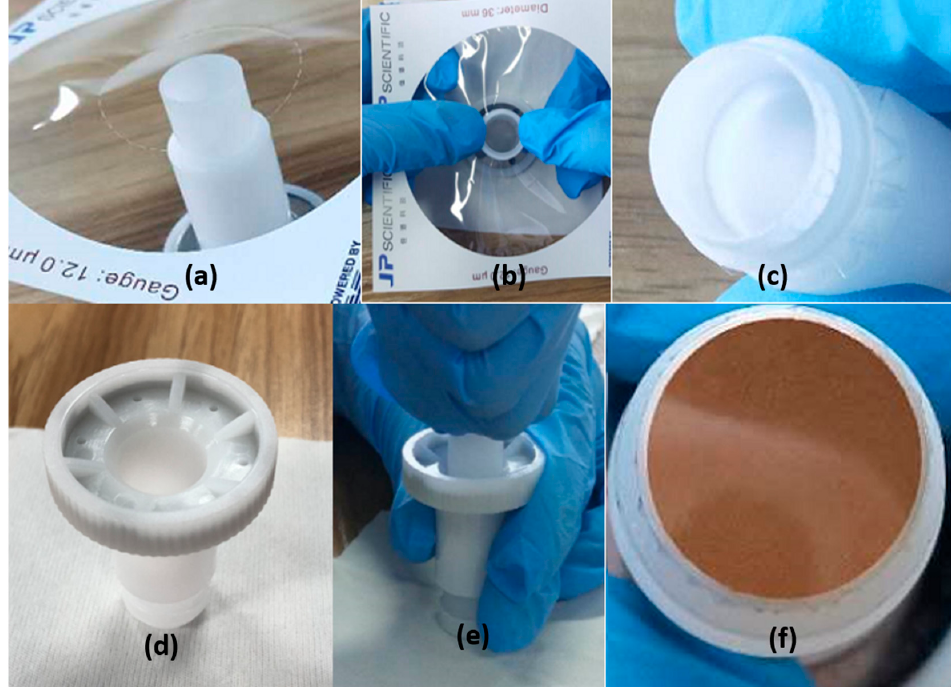
Figure 2. Sample preparation illustration.( a – c ) install polypropylene film, ( d – f ) load sample)